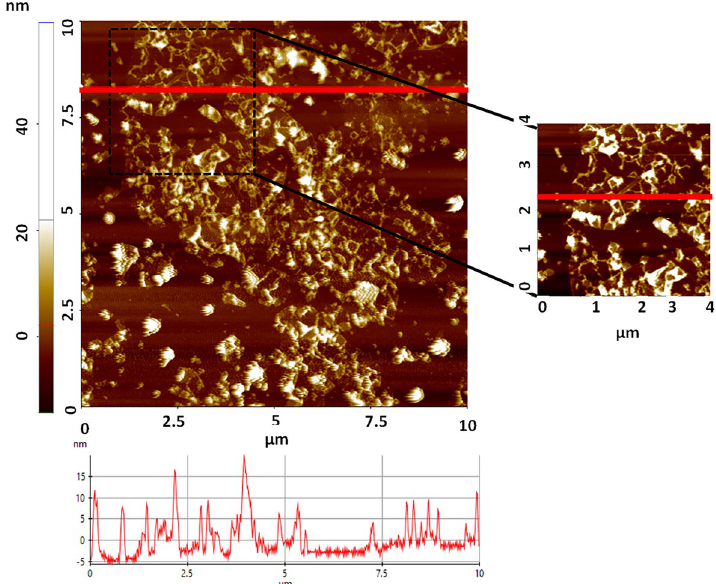
Figure 2. AFM image of GO